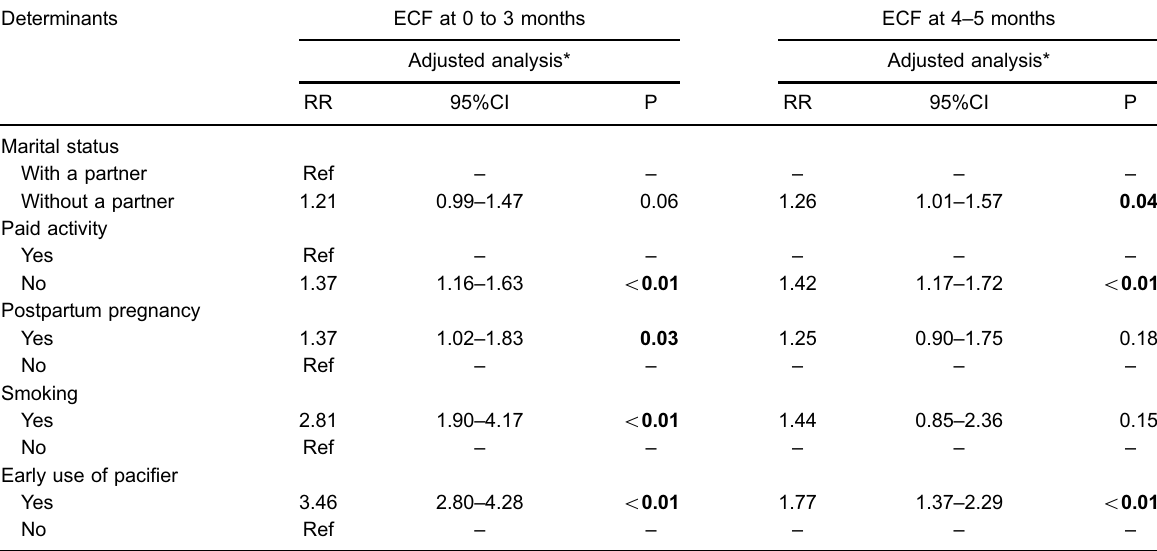
Table 4. Multinomial analysis for risk factors for introduction of early complementary feeding (ECF) of infants at 0 – 3 and 4 – 5 months of age in São Luis, MA, Brazil, 2010 – 2013.